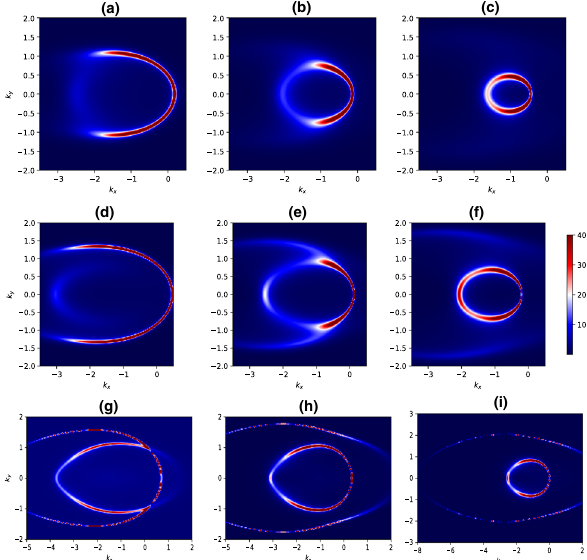
Fig. 1 Density plot of A ( k x , k y ) by varying the value of p 1 . Here, we fixed p 2 = 0 . 3 and m ψ = 0 , q = 1. Left to right: are for p 1 = − 0 . 2 , − 0 . 3 , − 0 . 4 , . The top, middle and bottom panel corre- spond to T /μ = 0 . 02 , 0 . 009 , 0 . 001 with m 2 φ = 0 and source χ ( 1 ) = 2